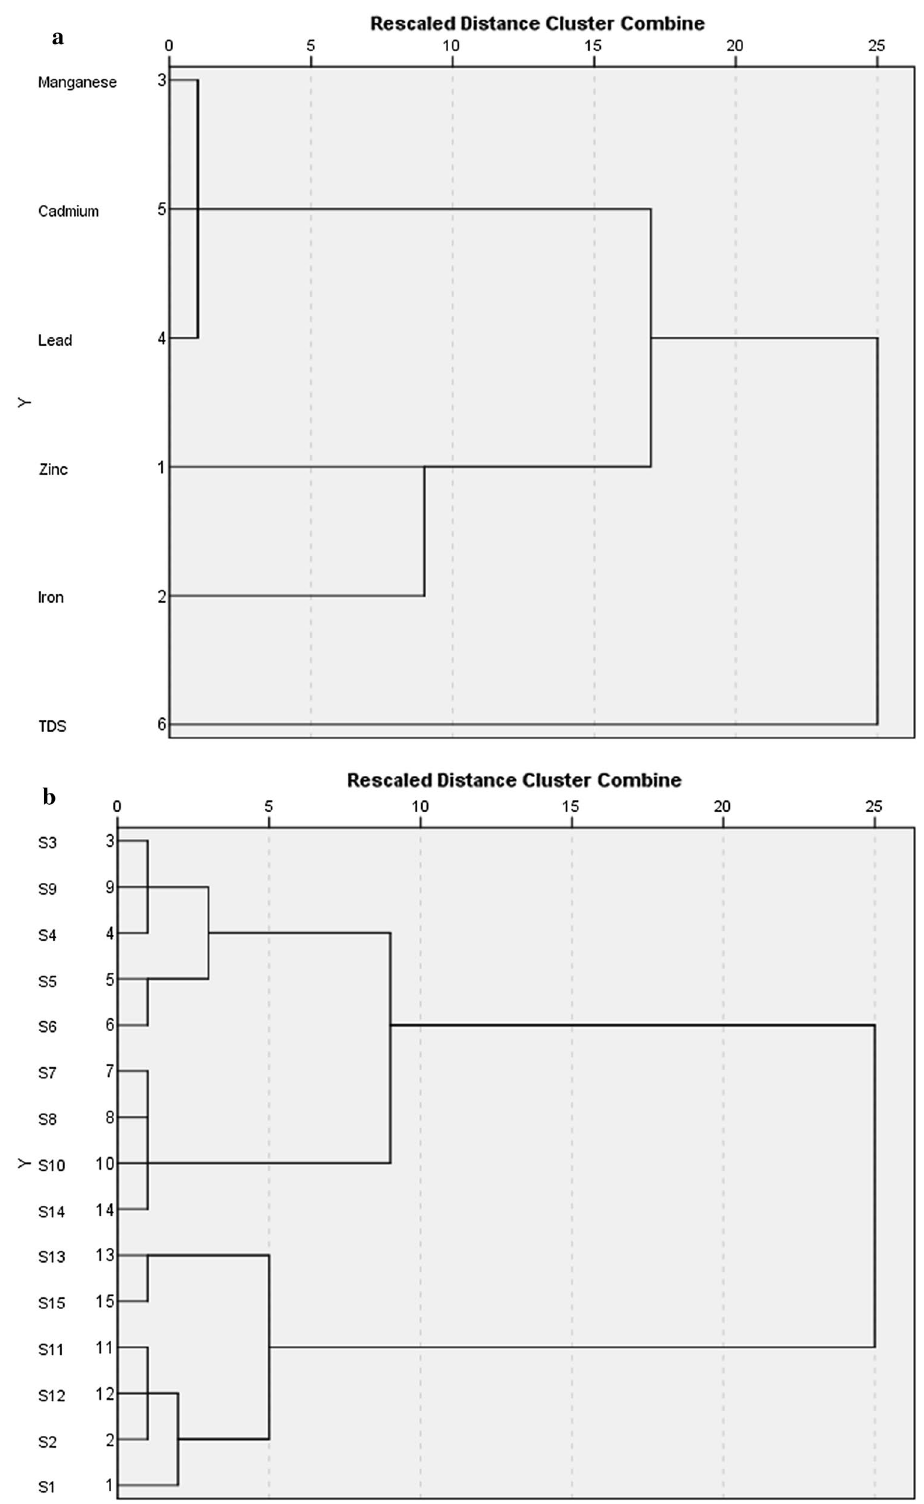
Fig. 5 A dendrogram classify- ing the water samples based on a analyzed parameters and b sampling